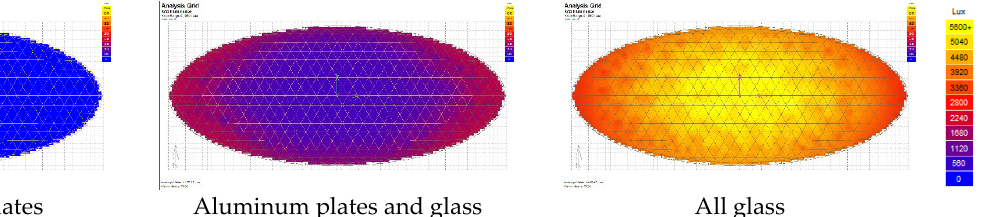
Figure 13. Atrium natural lighting illuminance distribution diagram. Table 4. Atrium illumination value (lux).